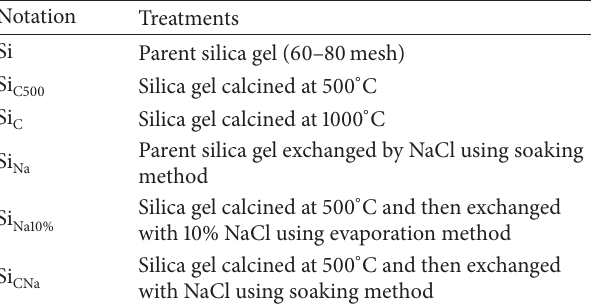
Table 1: The parent, calcined, and modified silica